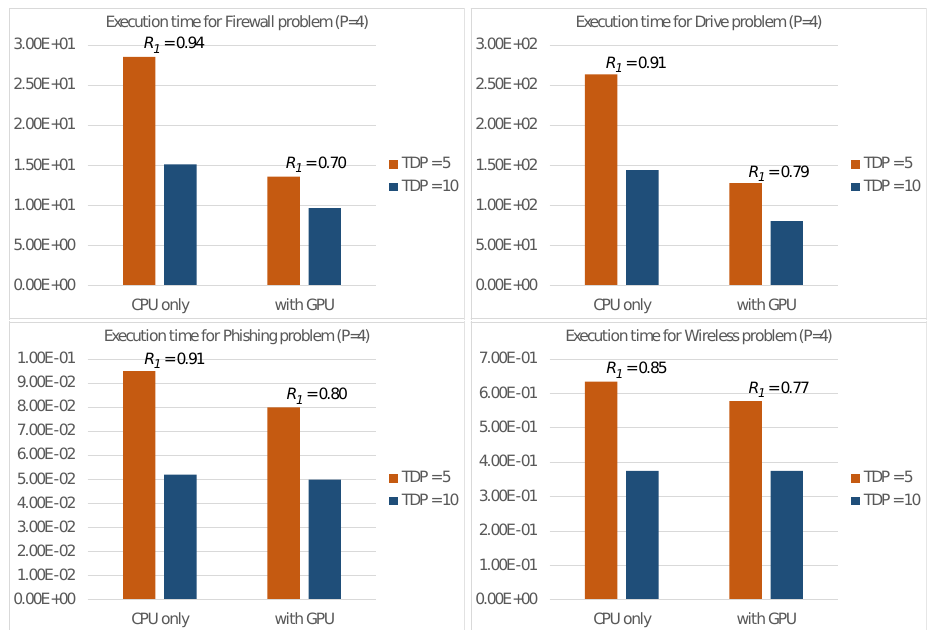
Figure 2. Execution times on the Nvidia Jetson Nano with the two settings 5 and 10 Watts and energy consumption ratio R 1